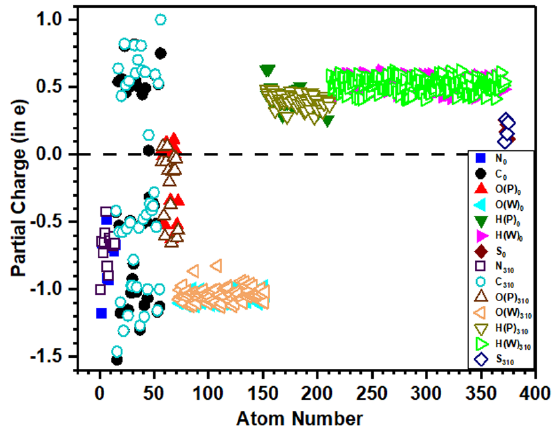
Figure 7. Calculated partial charge for each atom in solvated models of 1FUV at 0 K and 310 K. (The subscripts 0 and 310 denote the temperature 0 K and 310 K, respectively.). subscripts 0 and 310 denote the temperature 0 K and 310 K,